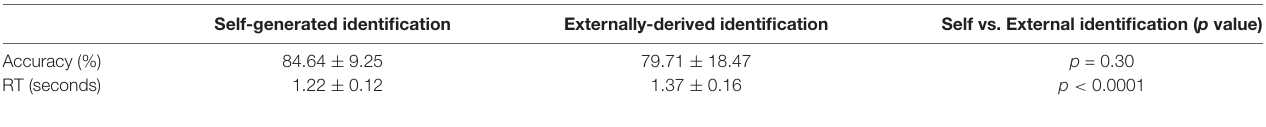
TABLE 2 | Reality-monitoring accuracy and reaction times